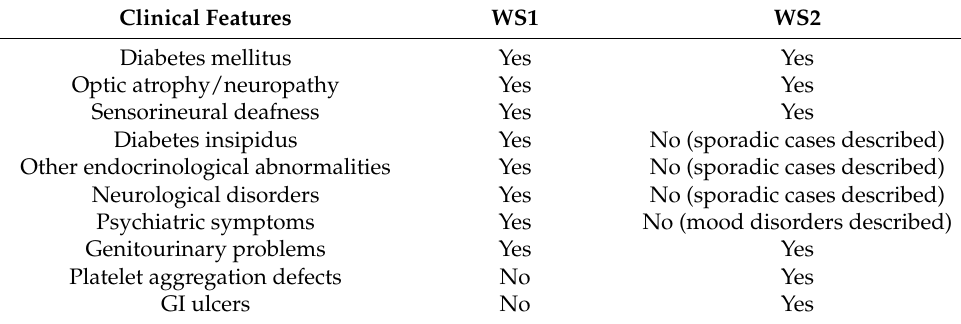
Table 2. Clinical differences between WS1 and